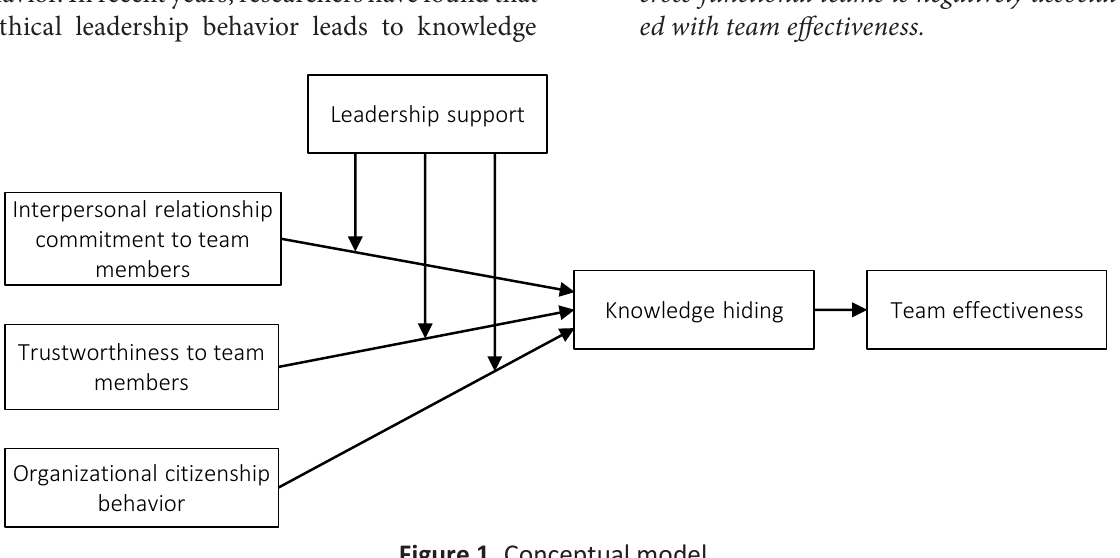
Figure 1. Conceptual